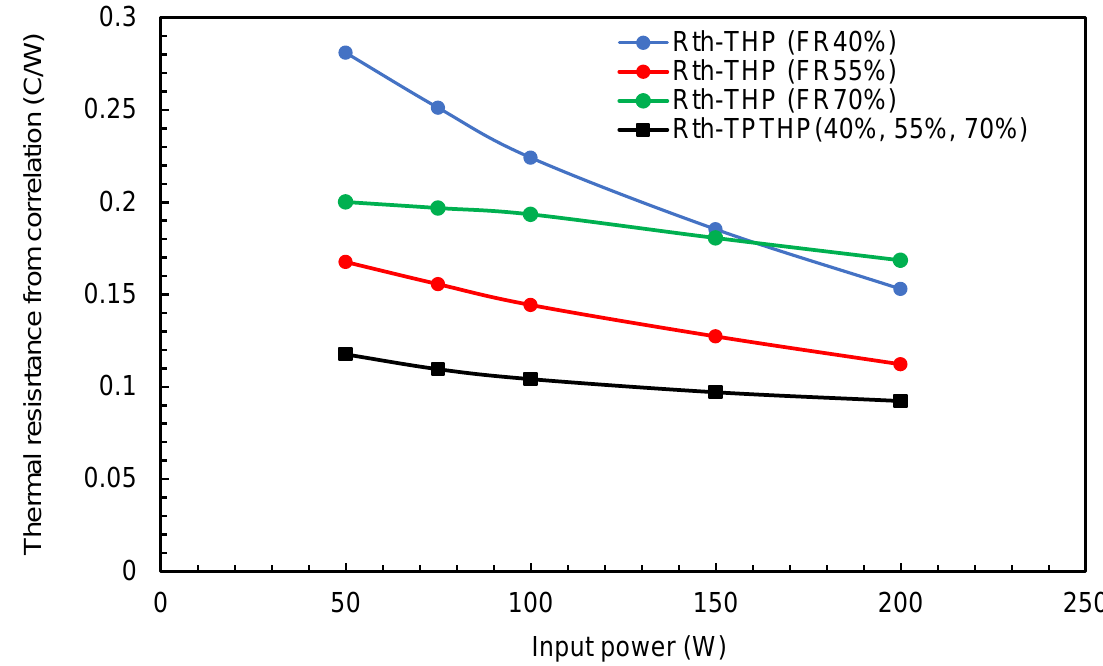
Figure 21. Variation of thermal resistance from correlations with input power for different inclination angles with and without TP (FR = 40%, 55%, and 70%).